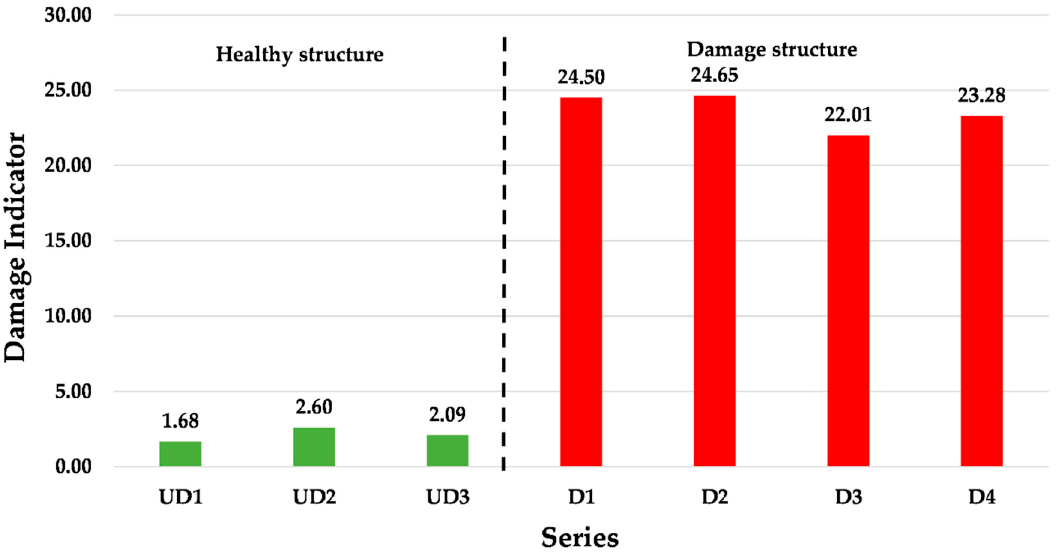
Figure 8. Values of the damage indicator. The green bars represent the structure in a healthy condition and the red bars show the damage indicator with the engraved structure. Table 1. Damage indicator values for all measurements in undamaged and damaged